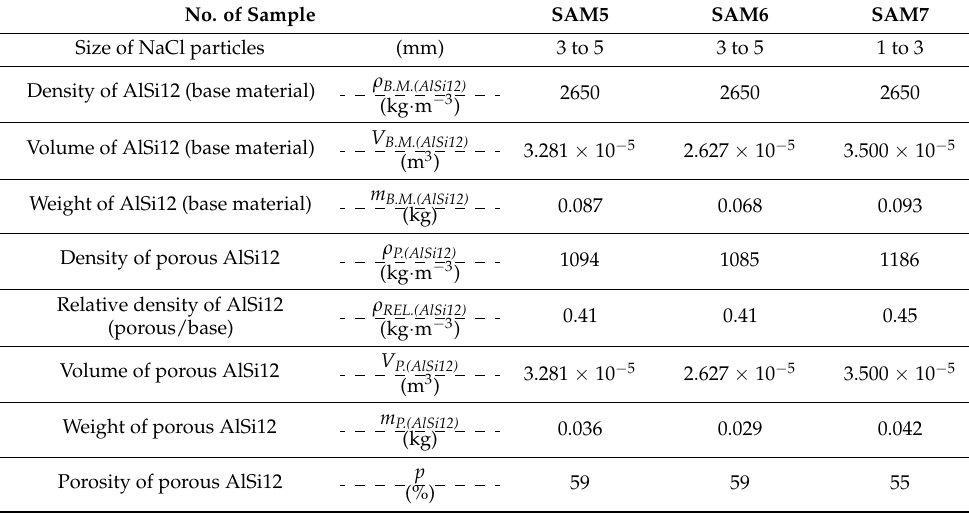
Table 6. Basic properties of base material and porous aluminium alloys (NaCl squeezed into alu- minium alloy melt)—samples